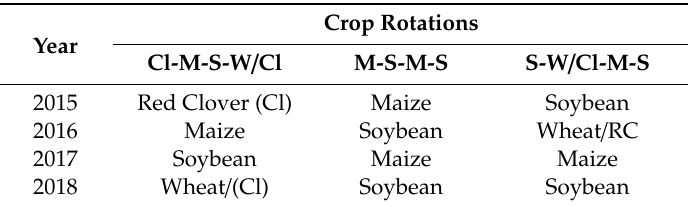
Table 1. Sequence of the red clover-maize-soybean-wheat / red clover (Cl-M-S-W / Cl), maize-soybean (M-S-M-S) and soybean-wheat / red clover-maize-soybean (S-W / Cl-M-S) rotations from 2015 to 2018 at